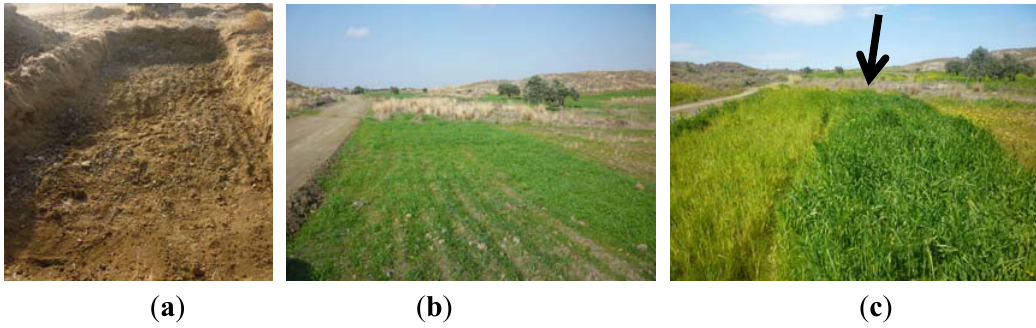
Figure 1. ( a ) Photo from the construction of the controlled archaeological environment located at the Alampra village. ( b ) The area was then cultivated with barley crops. ( c ) Photo of the barley crop during its full growth. The linear crop marks formed in the area above the archaeological environment is shown with an arrow.